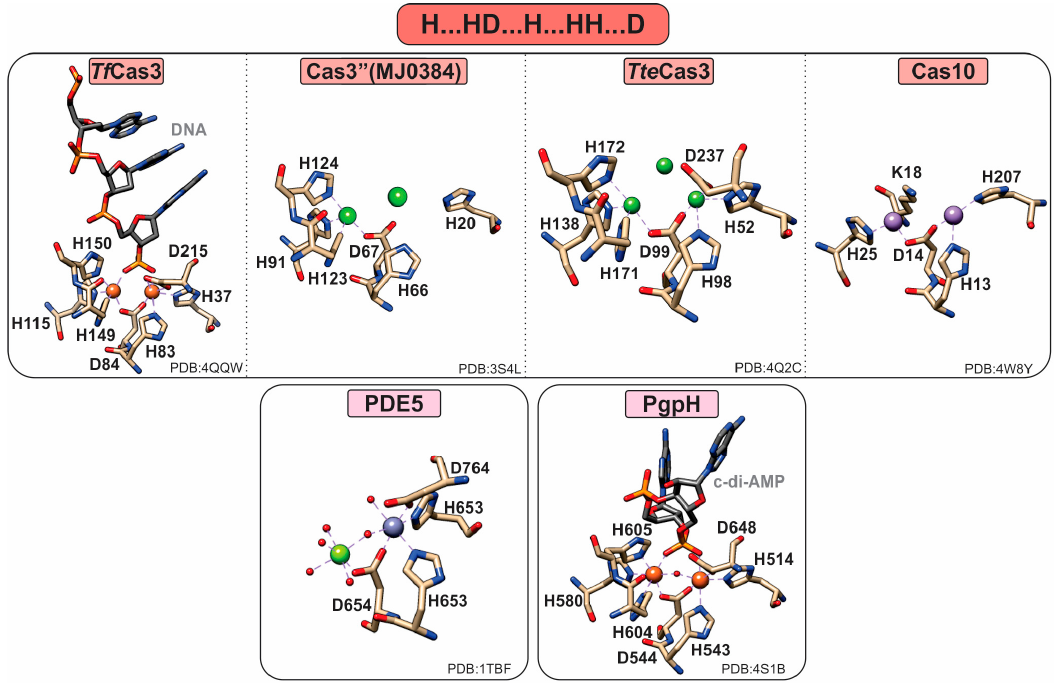
Figure 4. Active sites of HD-domain PDEs. HD-domain PDEs utilize the conserved HD motif “H…HD…H...HH...D” to bind a di- or trinuclear metal center. The metal ions coordinated in their active sites are zinc (purple), magnesium (light green), nickel (dark green), or iron (orange). Small red spheres represent water